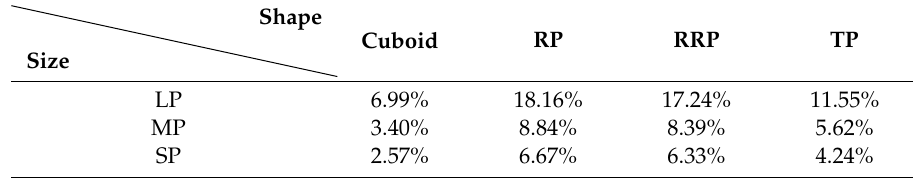
Table 1. Distribution table of pig manure (weight ratio).